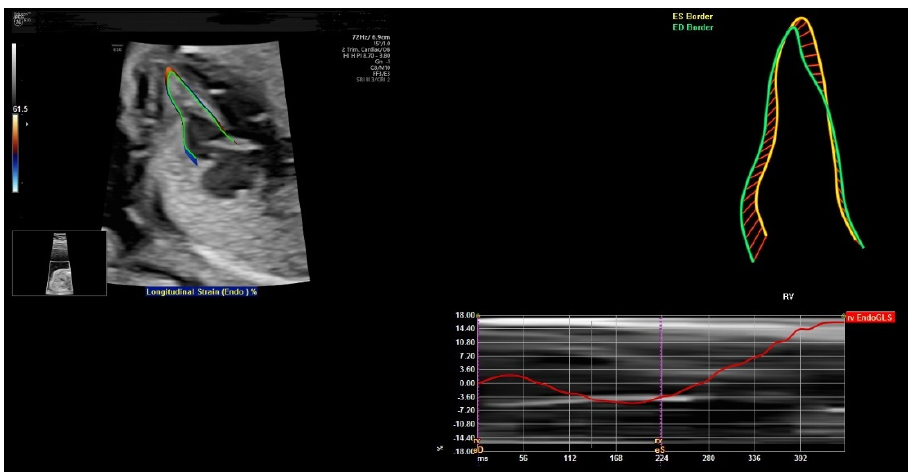
Figure 13. FetalHQ assessment of the fetal heart shape, size, and contractibility by using speckle tracking to analyze the motion of multiple points of the fetal heart at 20 weeks’ gestation.